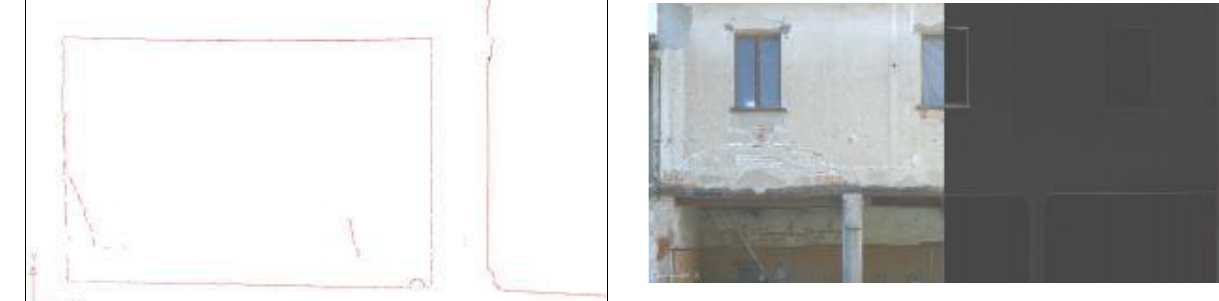
Figure 1. 2 mm slices representing a wooden beam edge, joists sections and column. The slice includes about 8000 points and can be surveyed into CAD environment.